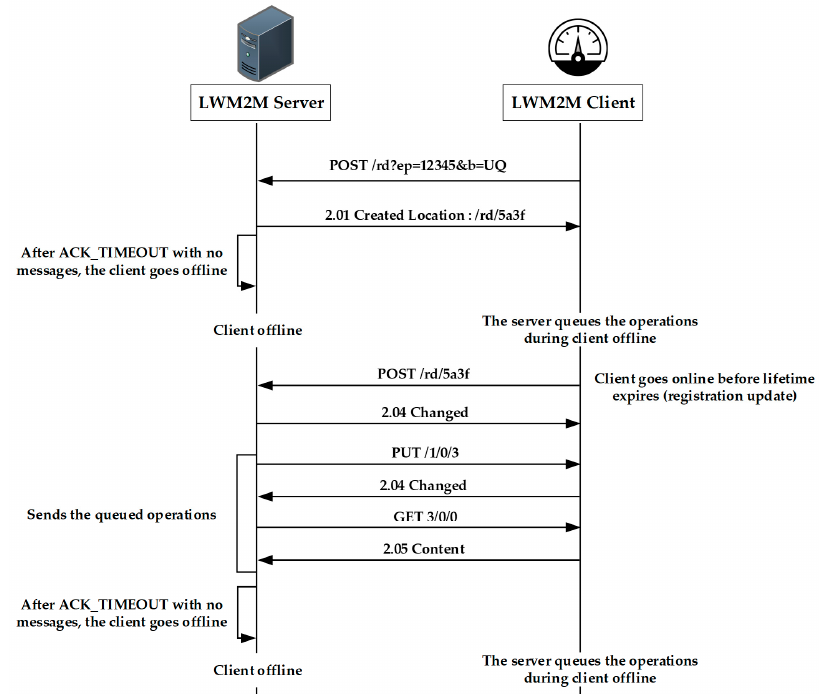
Figure 4. Lightweight Machine-to-Machine (LWM2M) operations.